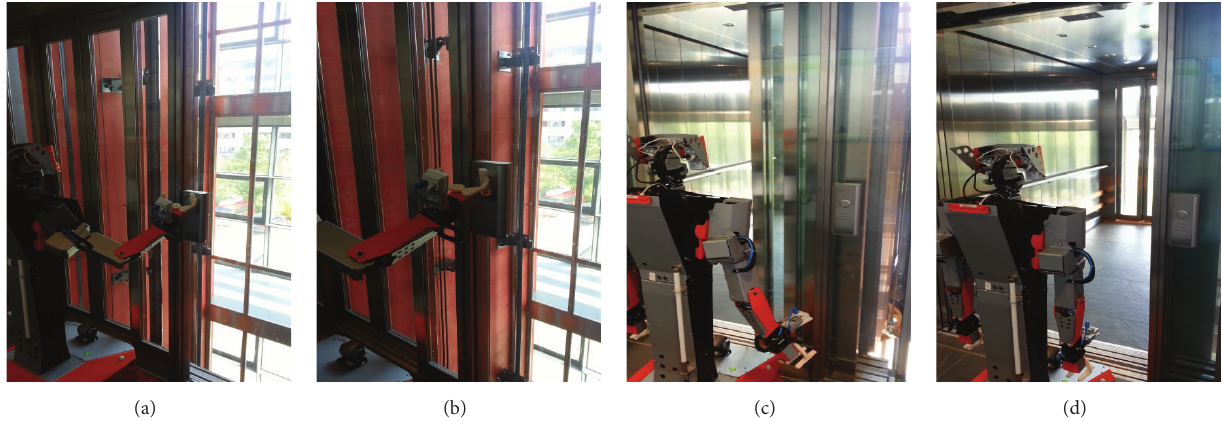
Figure 21: (a) Before the pressing. (b) Button pressing. (c) Robot arm returning to original position after pressing. (d) Ready to enter the